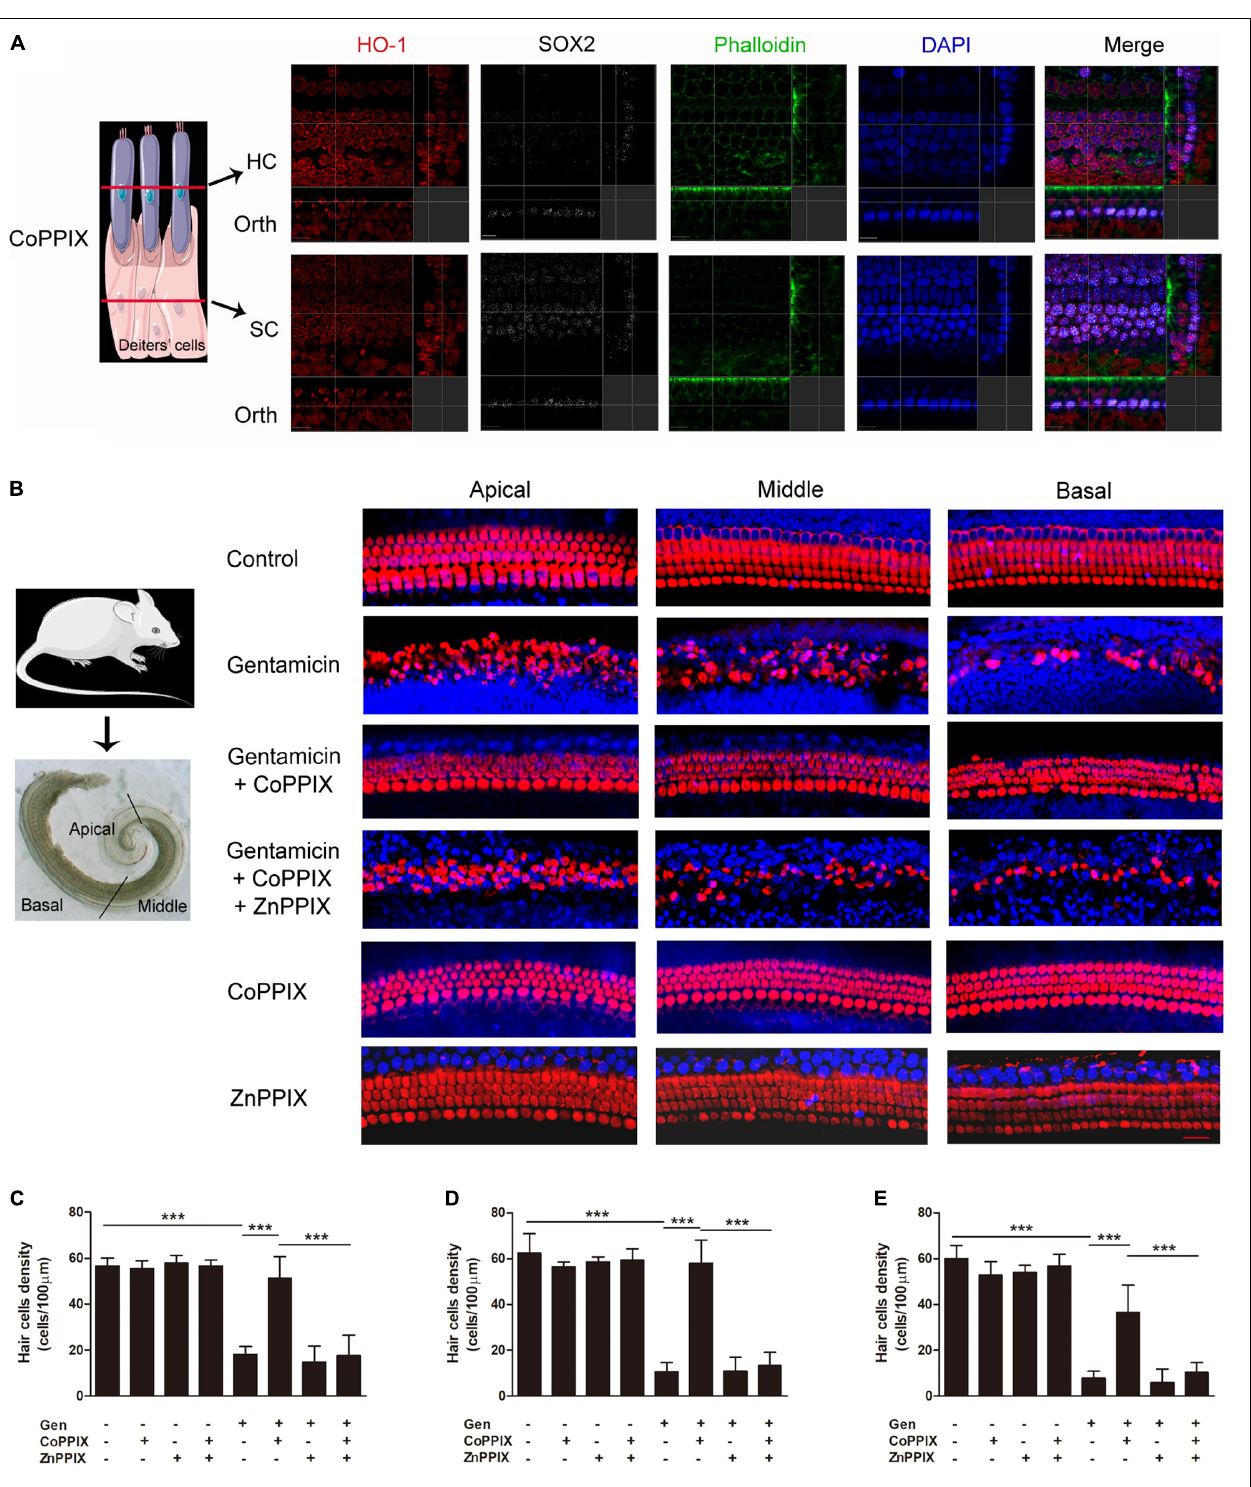
FIGURE 4 | Heme oxygenase-1 (HO-1) activation inhibited gentamicin-associated hair cell death. (A) The localization of HO-1 (red), phalloidin (green), SOX2 (white), and DAPI (blue) after CoPPIX treatment. The schematic showed the location of each panel. The upper panels show confocal images taken at the level of the hair cell cuticular plates; the lower panels show confocal images from the same field taken at the level of the supporting cell plates. Scale bar = 7 µ m. Orth, orthogonal. (B) Representative micrographs of immunofluorescent staining. Myosin VII-a was the marker of inner and outer HCs (red). Scale bar = 20 µ m. (C–E) Amounts of surviving HCs in various groups upon gentamicin-induced damage in the apical, middle, and basal turns (*** P < 0.001, n = 5).